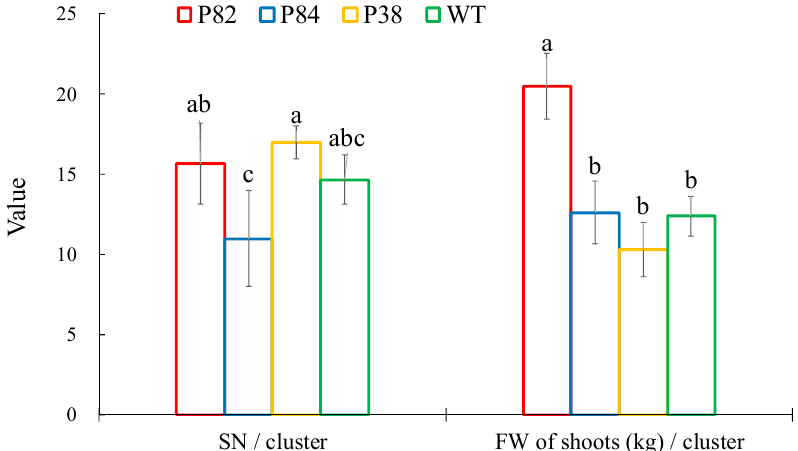
Figure 2. Comparison of the shoot number (SN) and fresh weight (FW) to some D. latiflorus lines. Mean ± SD (n = 3), different letters indicate significant differences at p < 0.05 level.